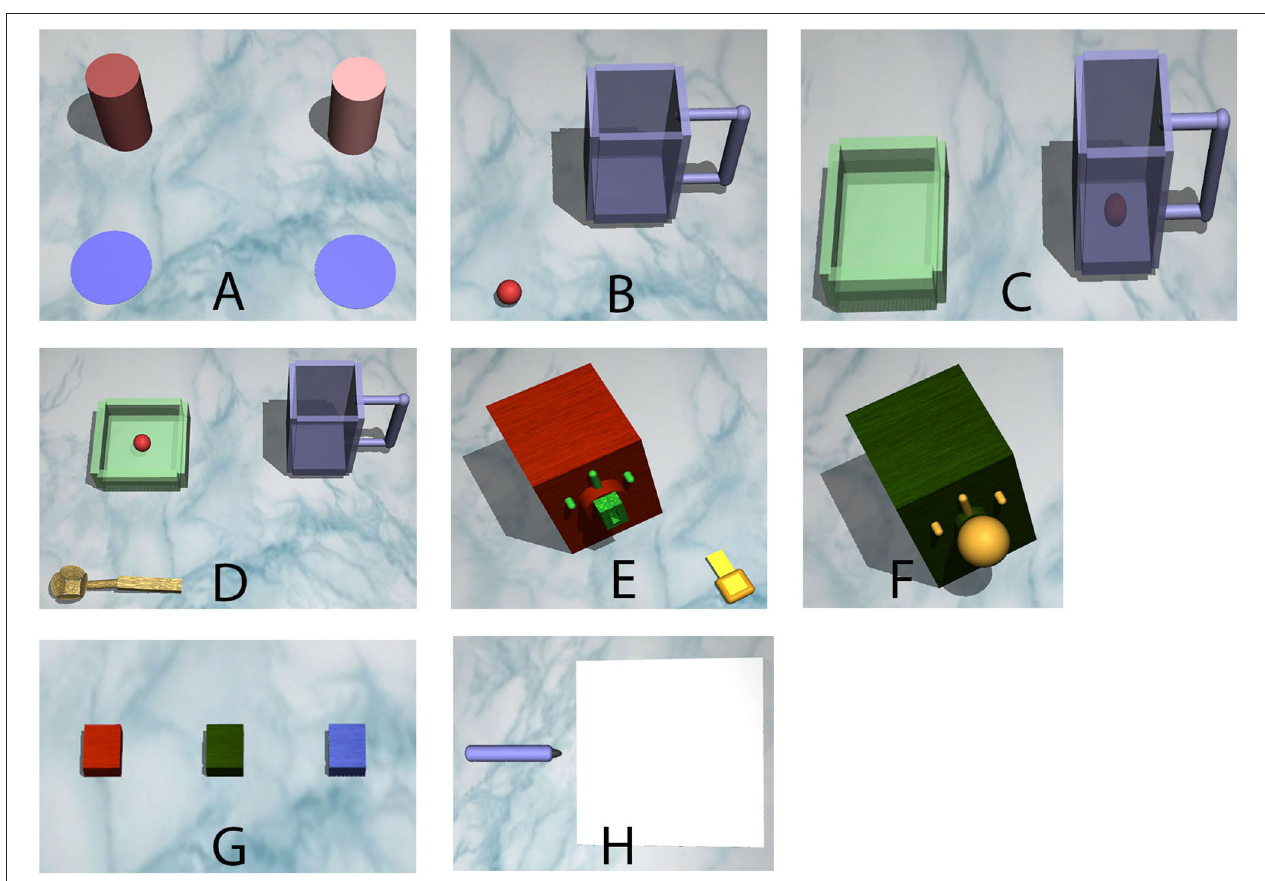
FIGURE 2 | The tasks that subjects completed. In order: (A) Task 1: move cans to targets, (B) Task 2: put ball in pitcher, (C) Task 3: pour ball in bowl, (D) Task 4: transfer ball with spoon, (E) Task 5: insert key and turn, (F) Task 6: turn knob, (G) Task 7: stack squares, and (H) Task 8: simulated writing.